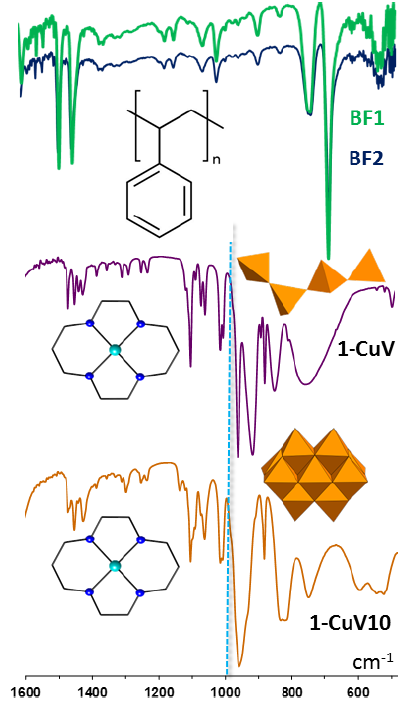
Figure A1. ATR-FTIR spectra of BF1 , BF2, and solid samples of 1-CuV and 1-CuV10 .